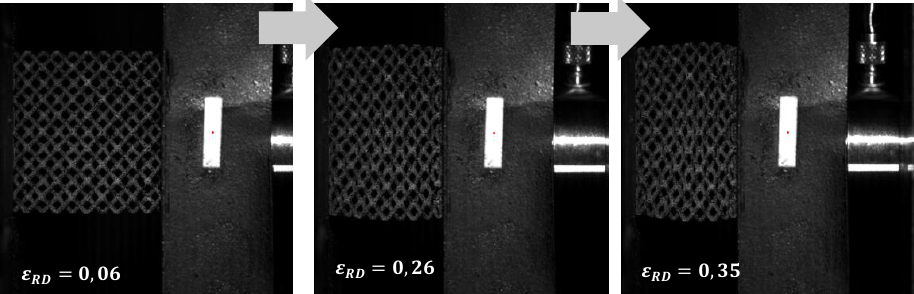
Fig. 7. RD cell : the first layer of RVEs experiences local buckling followed by a homogeneous compression state in each layer